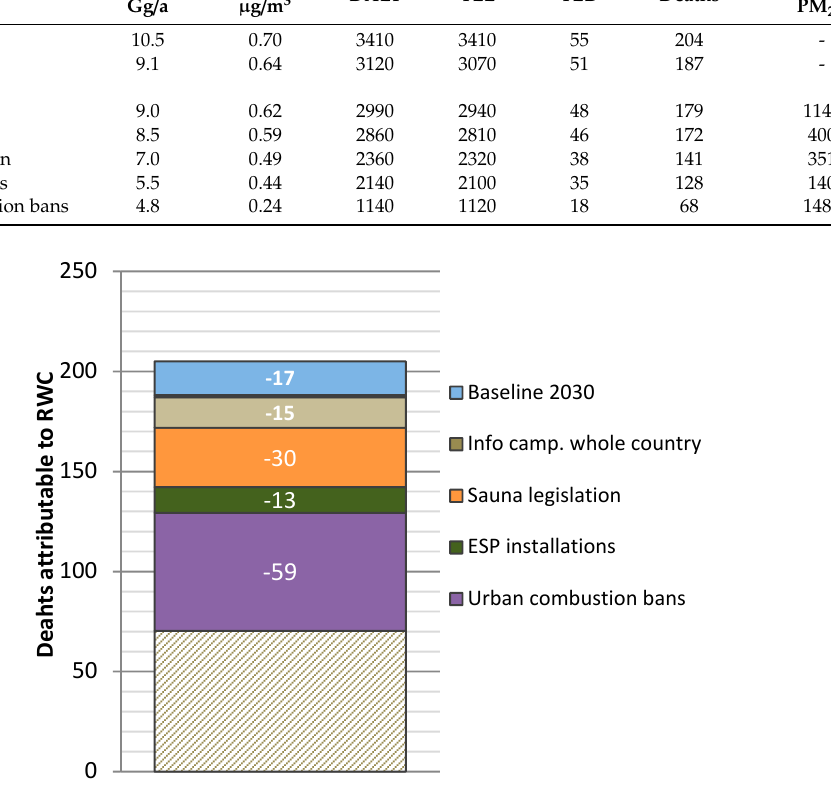
Figure 4. Reduction of annual deaths attributable to RWC in each scenario in 2030, with respect to the previous one, as new measures are added. Baseline 2030 has been compared to annual deaths in